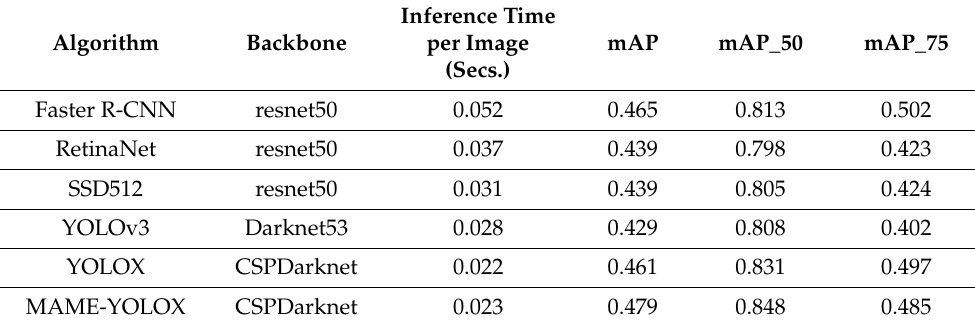
Table 2. Comparative experimental results of different algorithms on the AIBD dataset.